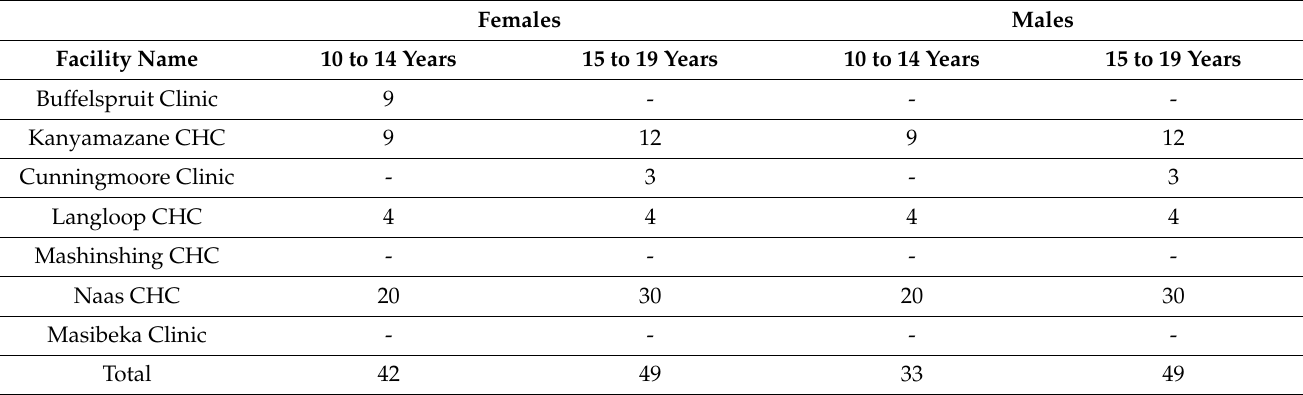
Table 1. Age and gender breakdown of ALHIV participating in the focus group discussions. Females